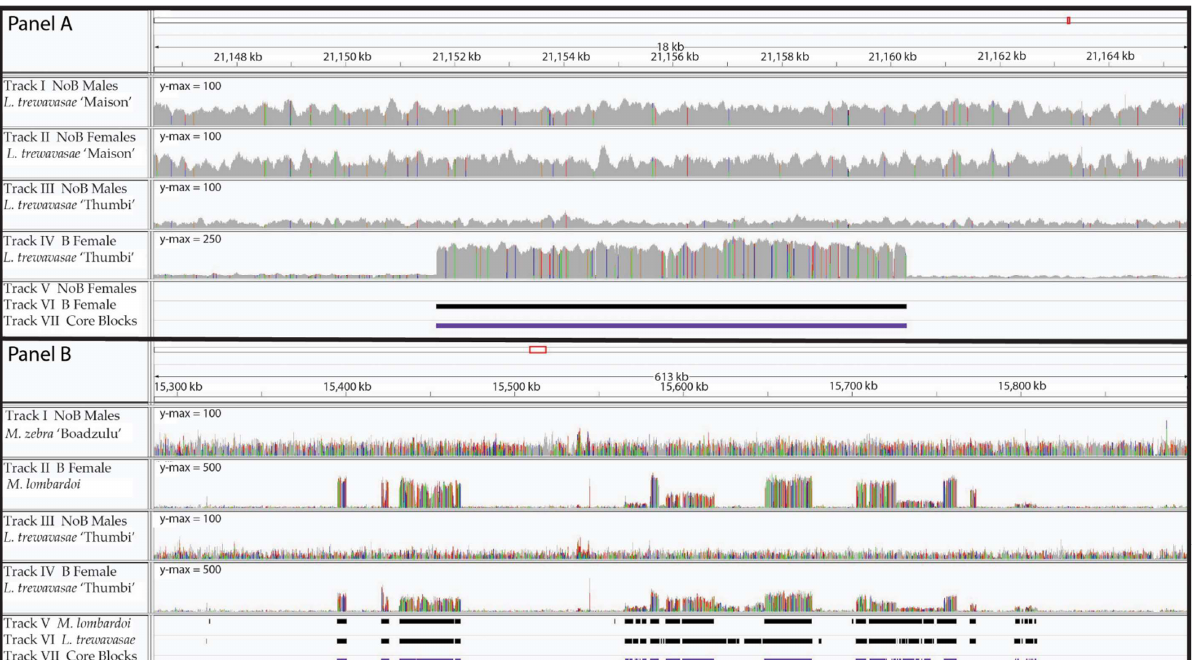
Figure 1. Read Coverage and B Blocks. B blocks from two genomic regions are shown with the corresponding read coverage. Panel ( A ) depicts an 18-kb region of LG8 with a typical B block. Tracks I and III are the male coverage ( Labeotropheus trewavasae “Maison” and L. trewavasae “Thumbi”, respectively), while tracks II and IV are the female coverage (NoB XX L. trewavasae “Maison” control and B L. trewavasae “Thumbi”, respectively). Please note the y-axis maximum is 100 for tracks I, II, and III but 250 for track IV. Beneath the coverage plots are the blocks detected by our analysis; track V shows the NoB XX female blocks, track VI shows the B female L. trewavasae blocks, and track VII shows the core blocks. A ~8.5-kb B block can be observed by the increased coverage in the B female L. trewavasae (track IV), but no such increased coverage is observable in the other coverage plots. Our B block analysis pipeline identified the B female L. trewavasae block (track VI) but did not identify a block in the NoB XX female control data (track V). As this B block was similarly found in at least 12 of the 13 datasets, it is included in the core block set (track VII). Panel ( B ) depicts several B blocks in close proximity to one another across a 613-kb region of LG23. Tracks I and III are again male coverage but for M. zebra “Boadzulu” and L. trewavasae “Thumbi”, respectively. Tracks II and IV both depict B female coverage (B Metriaclima lombardoi and B L. trewavasae “Thumbi”, respectively). Please note the y -axis maximum is 100 for tracks I and III but 500 for tracks II and IV. The block sets detected in the B female M. lombardoi (track V), B female L. trewavasae “Maison” (track VI), and the core blocks (track VII) are shown below. B blocks can be observed in the coverage of both B females (tracks II and IV) and correspond well with the blocks identified through our B block identification analysis (tracks V, VI, and VII). The B blocks span ~420 kb and appear to have migrated to the B as a single unit in the ancestor of M. lombardoi and L. trewavasae